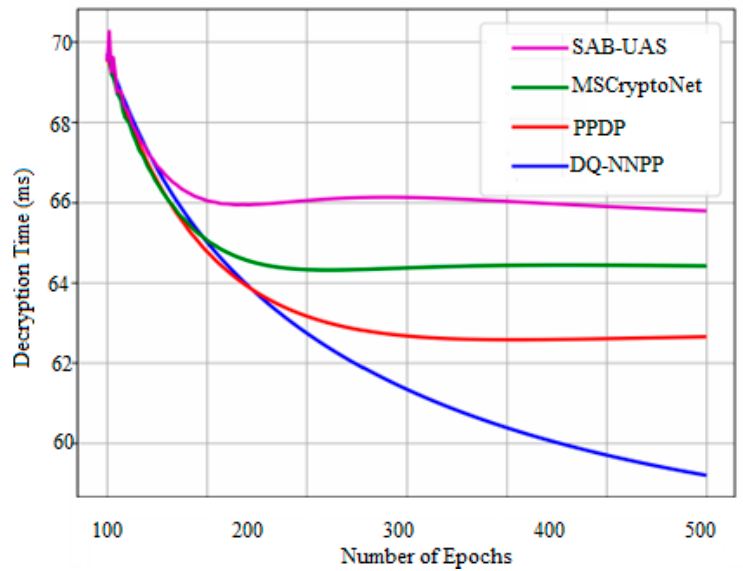
Figure 9. Comparison of decryption time. Table 1. Overall comparison between proposed and existing methods.